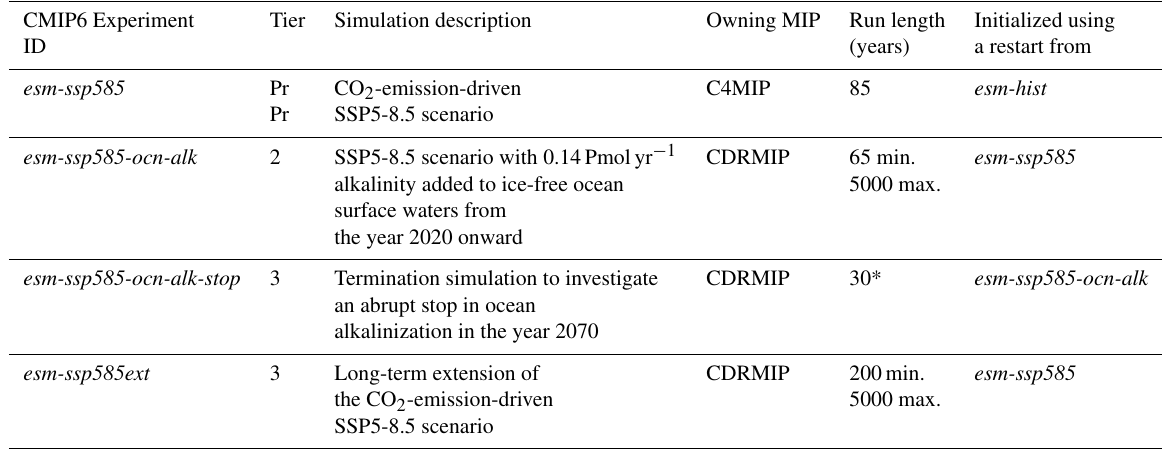
Table 7. Ocean alkalinization ( CDR-ocean-alk ) experiment simulations. “Pr” in the Tier column indicates a prerequisite experiment. CMIP6